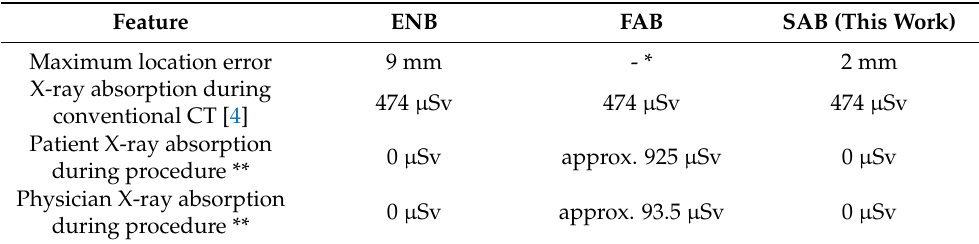
Table 1. Comparison of features of competing